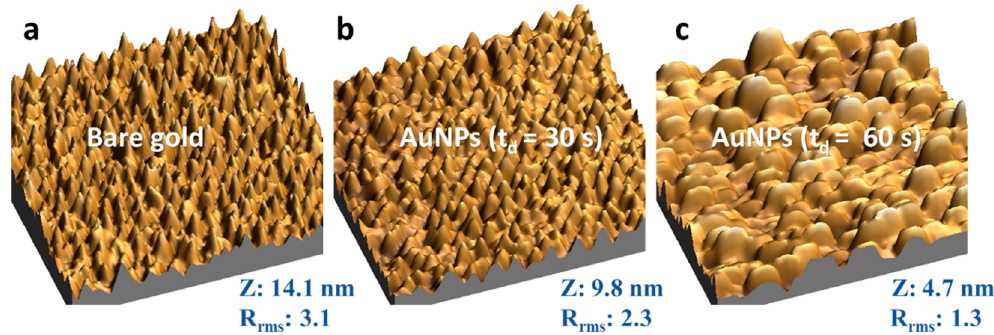
Figure 2. Three-dimensional AFM images (1 µ m × 1 µ m) of the gold electrode before and after AuNPs electrodeposition by controlled potential electrolysis with 0.0 V applied potential in a solution of 0.25 mM HAuCl 4 with NaNO 3 . The Z corresponds to the average height, and R rms is the root mean square average roughness factor of each sample. ( a ) bare gold electrode; ( b ) after AuNPs electrodeposition with td = 30 s; ( c ) after AuNPs electrodeposition with td = 60 s.